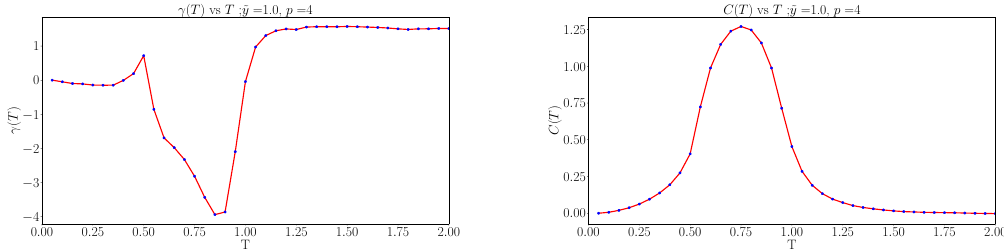
Figure 11 . The (cid:12)tting of I ( X ; Y; T ) to C ( T ) N + (cid:13) ( T ) for p = 4 and ~ y = 1. The data is obtained from (cid:12)tting lattice sizes N = 8 to N =